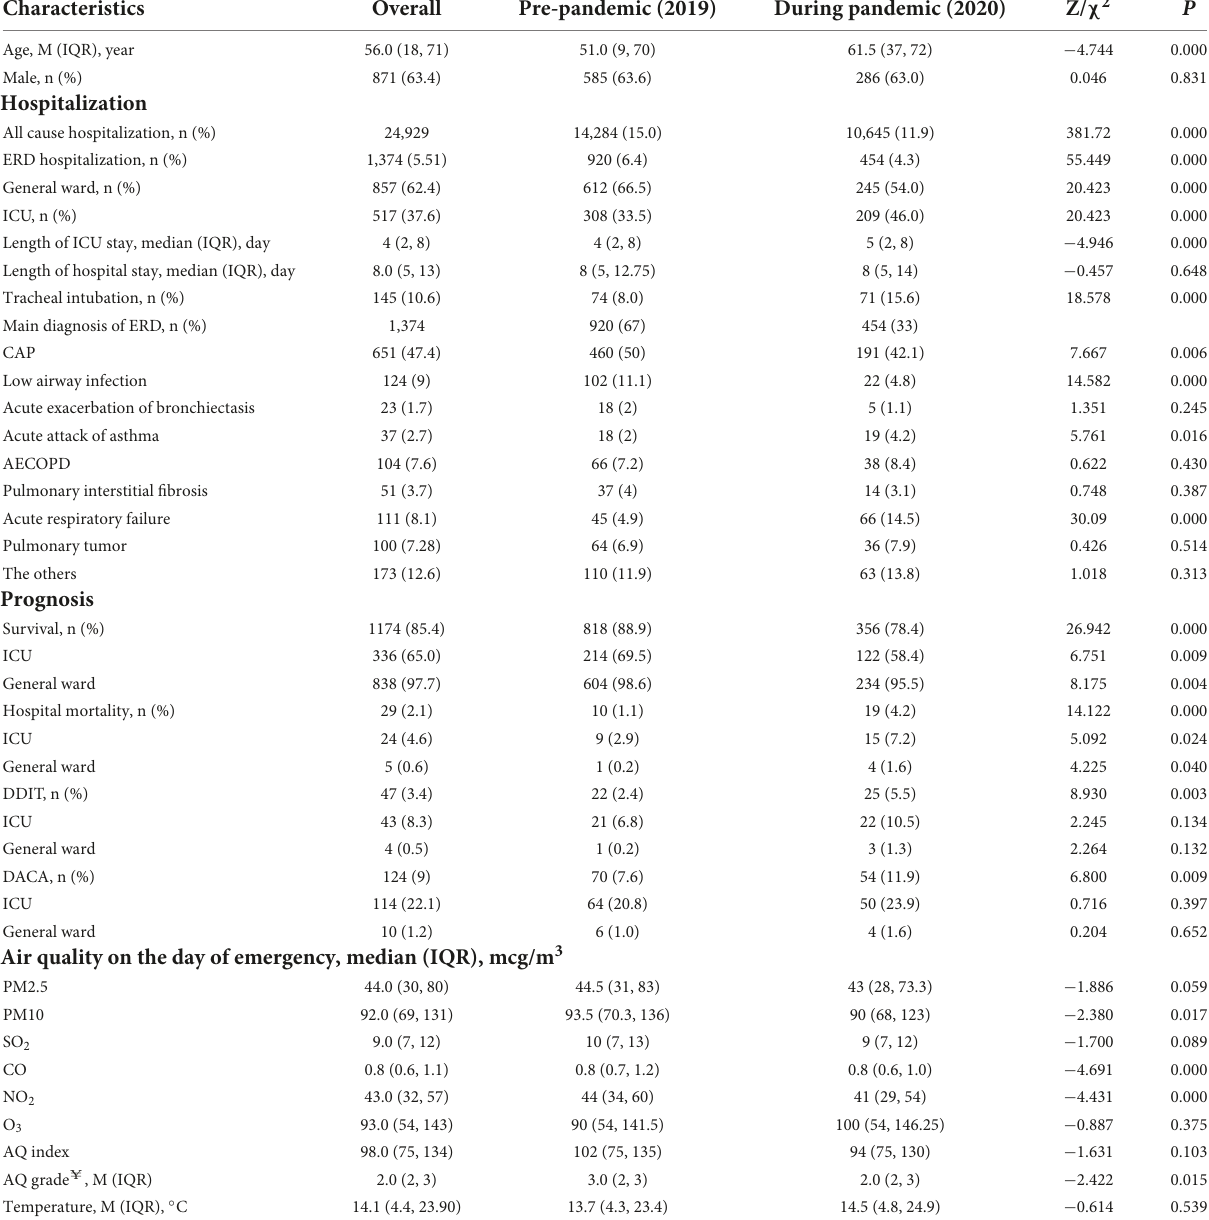
TABLE 1 Clinical characteristics of hospitalized patients due to ERD, air quality on the day of hospitalization. Characteristics Overall Pre-pandemic